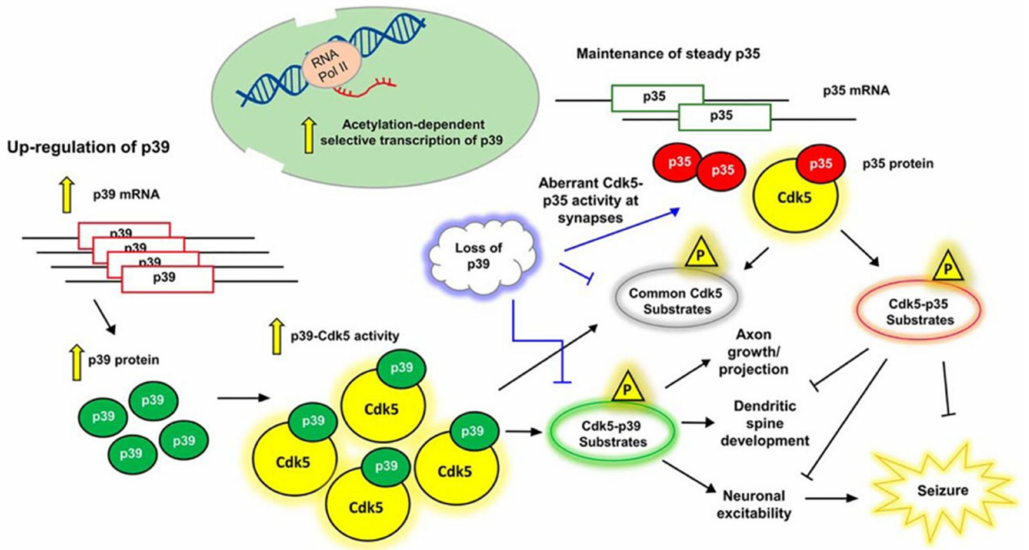
Figure 1. Functional diversity and cooperation by Cdk5 (cyclin-dependent kinase 5) activators in postnatal brain neurons (Adopted from reference 29)